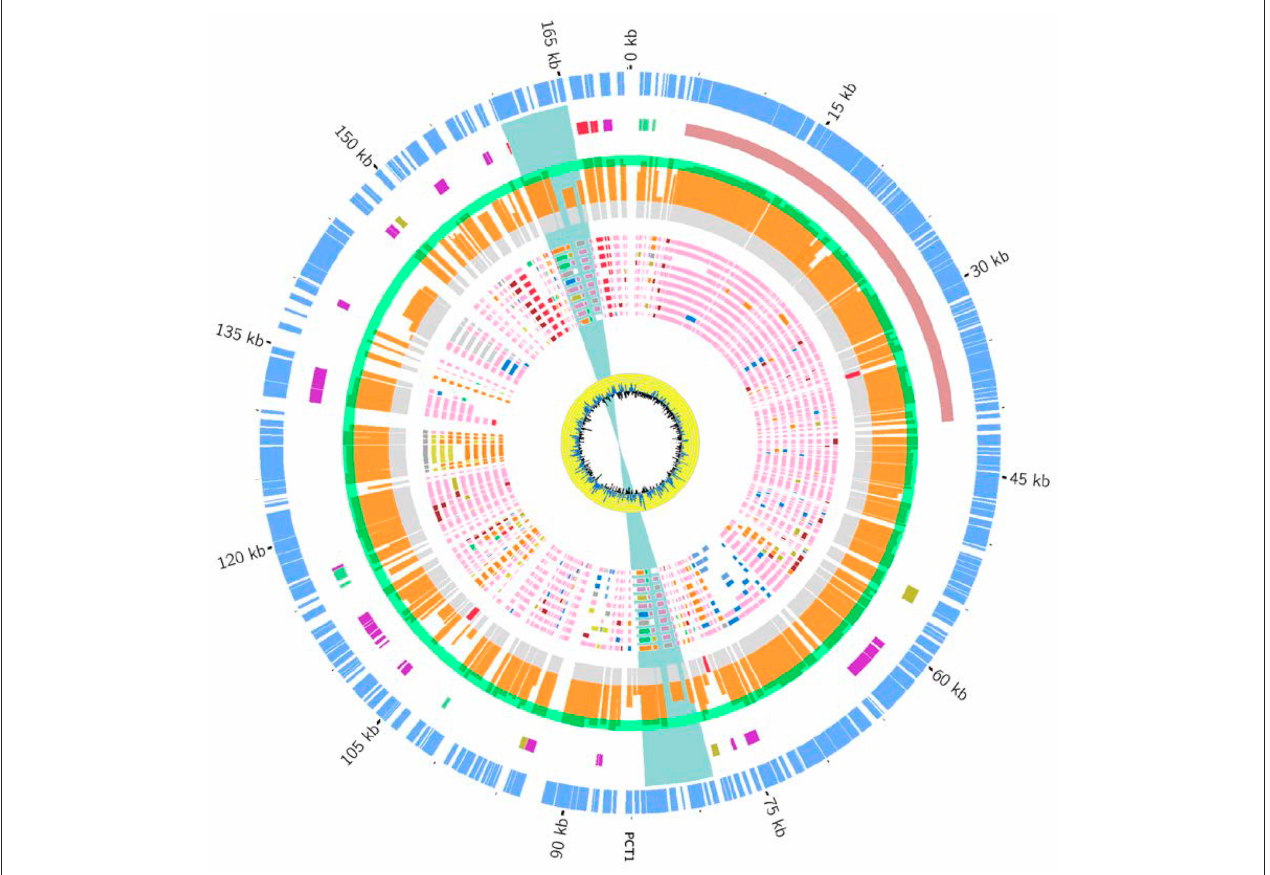
FIGURE 4 | Overview and organization of the pCitro1 plasmid. From outside to inside circles. The light blue tiles are the pCitro1 ORFs. The violet tiles are Transposases/Resolvases; the ORFs related to the Y. pestis pPCP1 are in red; the tra operon is in dark blue and the blue ribbon indicates a 5kb inverted repeat. The protein sequence identity with its best blast hit is plotted in the continuous gray (twilight zone < 25%), orange (25–90%), and light green ( > 90%) circles. Below, ten circles showing the taxonomic origin of the ten best blast hits of each protein. Pink, orange, blue and red tiles belong to Escherichia , Citrobacter , Klebsiella and Yersinia genera, respectively. The yellow circle plot is the GC